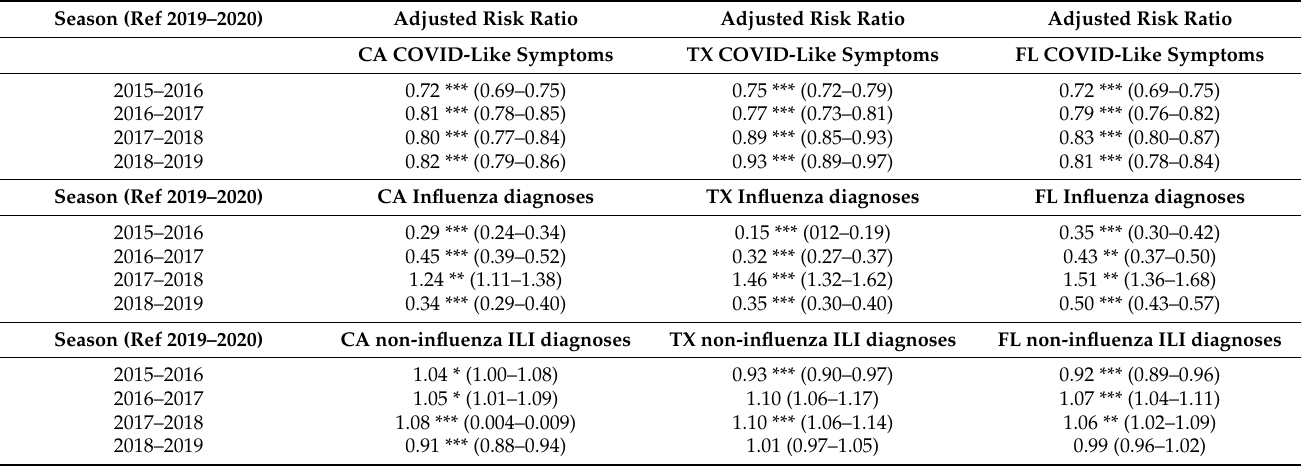
Table 2. Adjusted Risk Ratios between 23 weeks (1 October–29 February 29) of 2019–2020 flu season compared to each of four previous seasons for ED visits among VA patients with CLS, influenza, and non-influenza ILI by